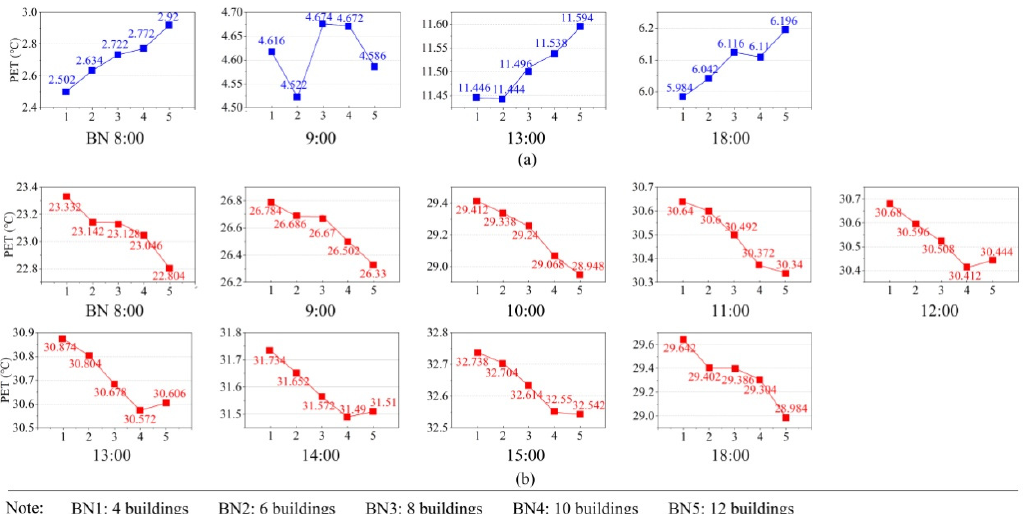
Figure 10. Effect diagrams of building number (BN) in winter and summer: ( a ) effect diagrams of BN in winter and ( b ) effect diagrams of BN in summer.